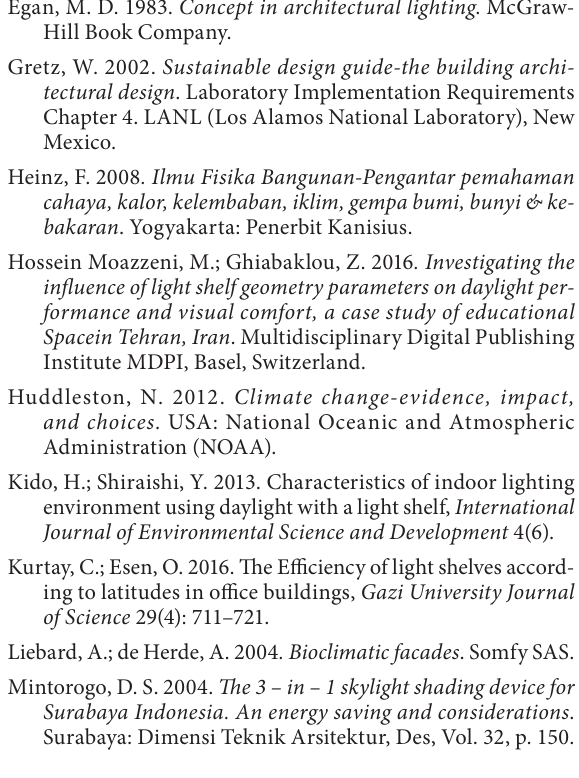
The graph shows that the condition of the building without light-shelf from morning to evening (started at 7 a.m. until at 5 p.m.). The air temperature was higher compared with the condition of the building using multiple light shelves. The difference between the highest temperatures happened at the peak of working activity from 9 a.m. to 3 p.m.